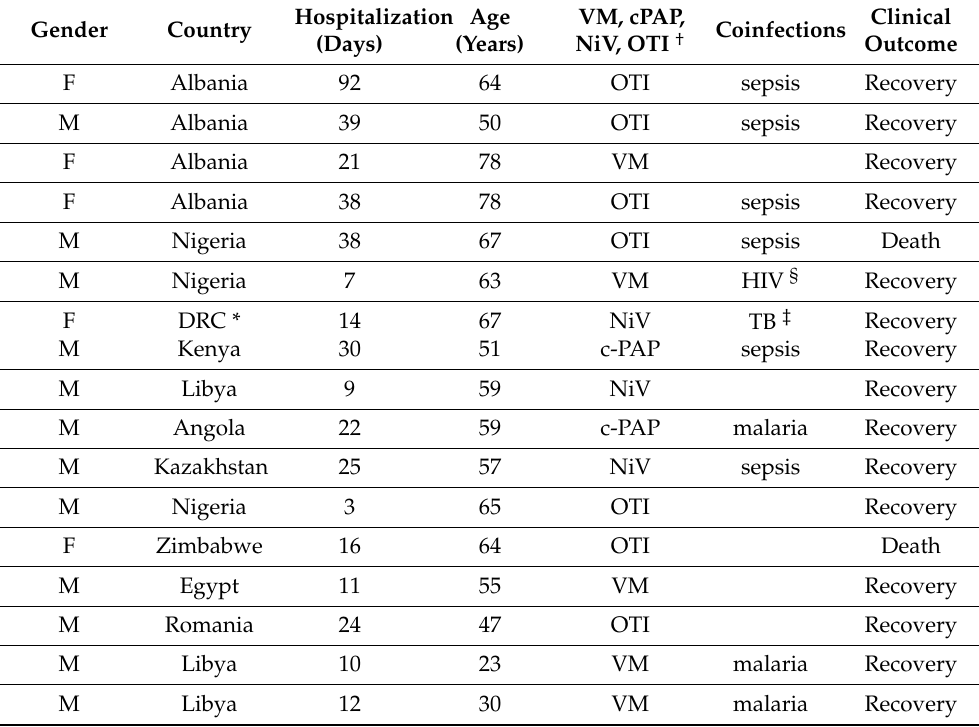
Table 1. Gender, country of departure, hospitalization time expressed in days, age, ventilatory support, concomitant infections and clinical outcome. Gender